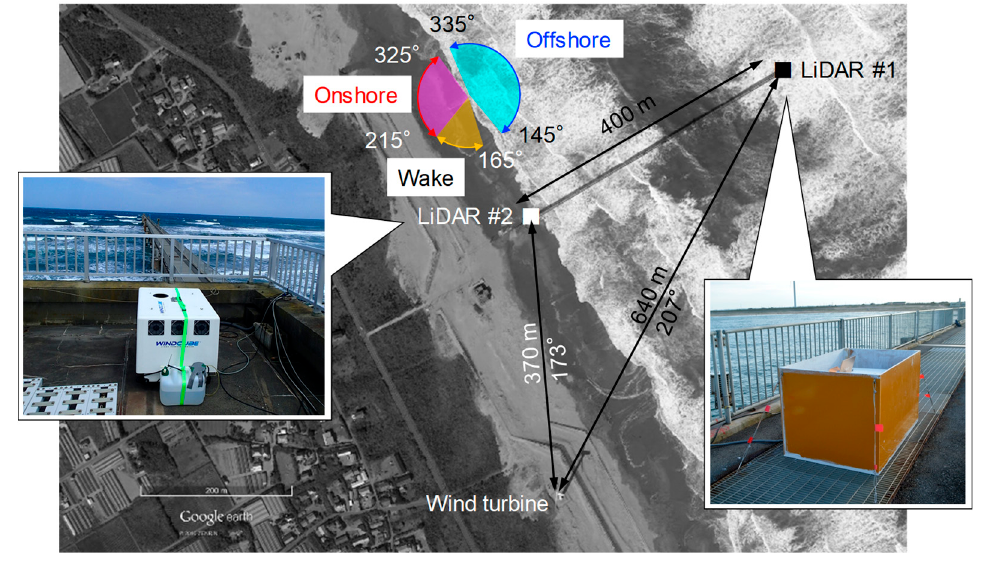
Figure 2. Experimental setup.